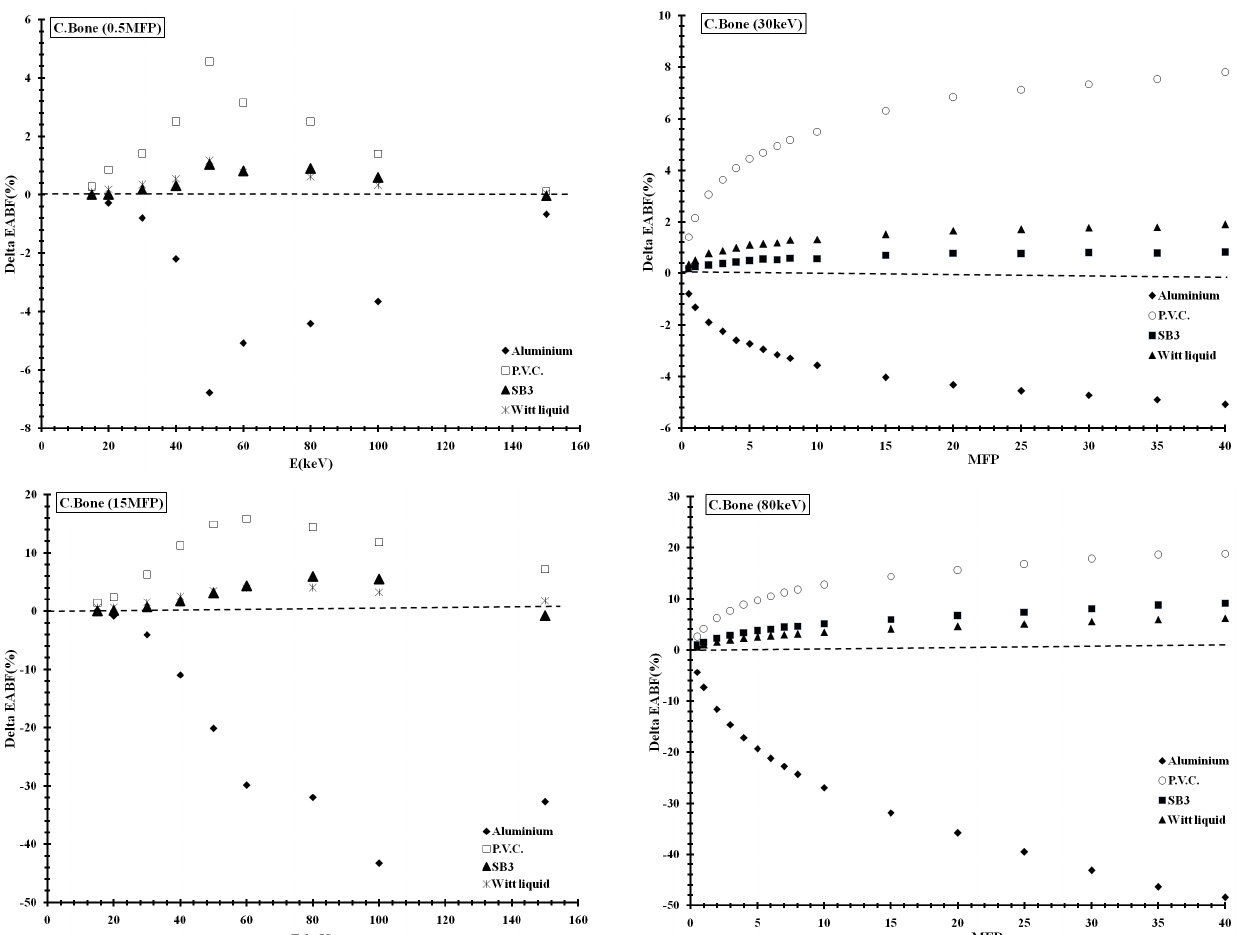
Figure 4. Energy absorption buildup factor for cortical bone tissue as a function of: ( left side) photon energy for fixed depths between 0.5 and 40 mfp and ( right side) depth for fixed photon energy between 15 and 150 keV.